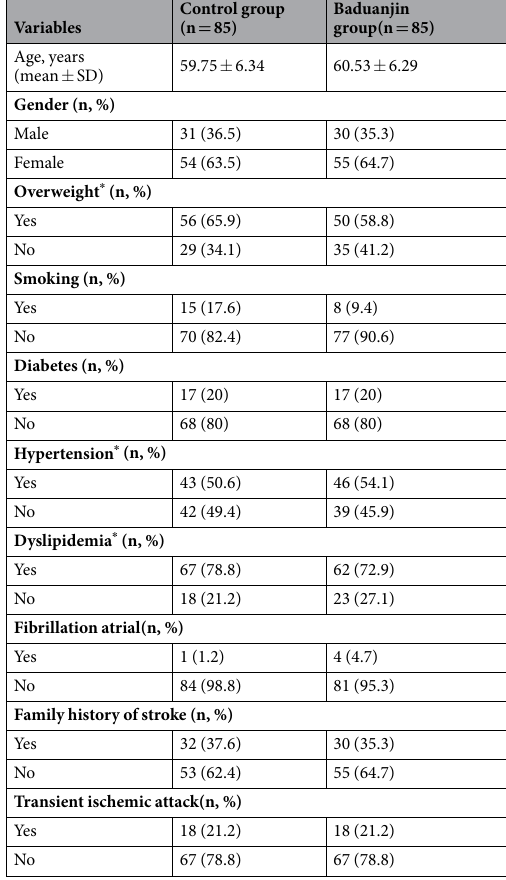
Table 1. Baseline demographic characteristics of participants between Baduanjin group and control group.